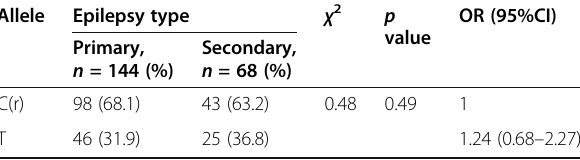
Table 6 Association between MDR1 C3435T SNP and epilepsy types (primary and secondary) MDR1 C3435T genotype